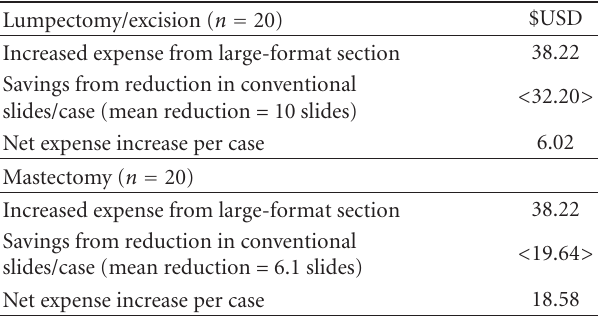
Table 9: Imaging-guided large-format breast pathology net incre- mental technical expense per case. $USD,